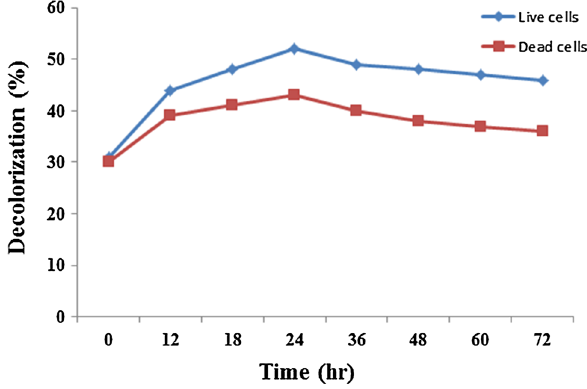
Fig. 8 Decolorization of methylene blue by both live and heat-killed cells of Stenotrophomonas